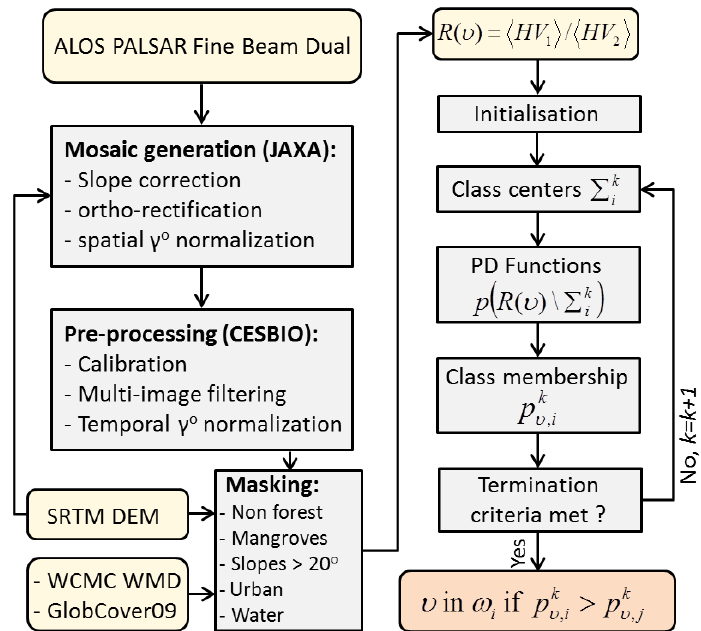
Figure 4. Flowchart representing the forest disturbances and regrowth detection method. SRTM DEM is the Shuttle Radar Topography Mission digital elevation model; WCMC WMD is the World Conservation Monitoring Centre world map of mangrove distribution; and PD is the probability density. (cid:104) HV 1 (cid:105) is the average intensity at Date 1; R ( ν ) = (cid:104) HV 1 ( ν ) (cid:105)|(cid:104) HV 2 ( ν ) (cid:105) is the intensity ratio of a homogeneous region centered at pixel position ν in the image; Σ k and k is the current iteration